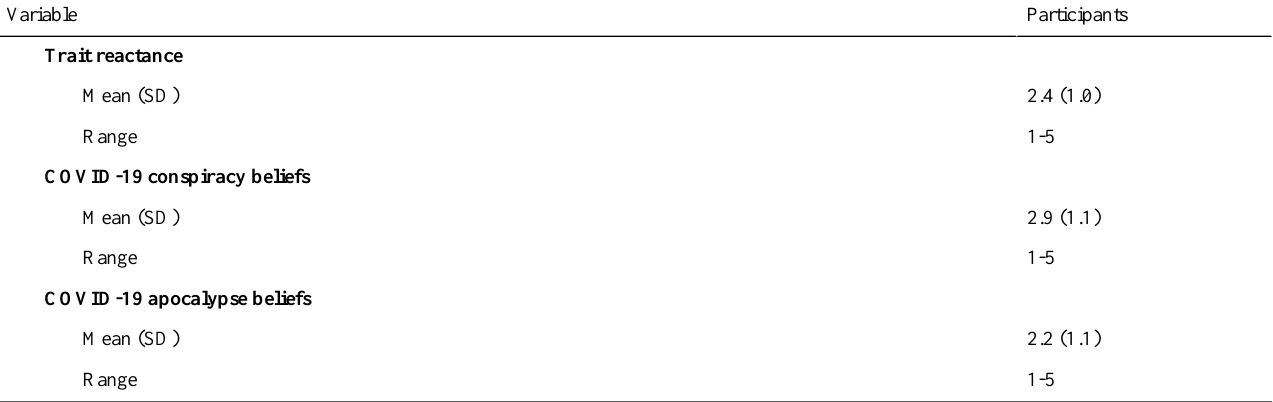
Table 2. Pearson correlations of novel predictors and COVID-19 outcomes (N=1074).